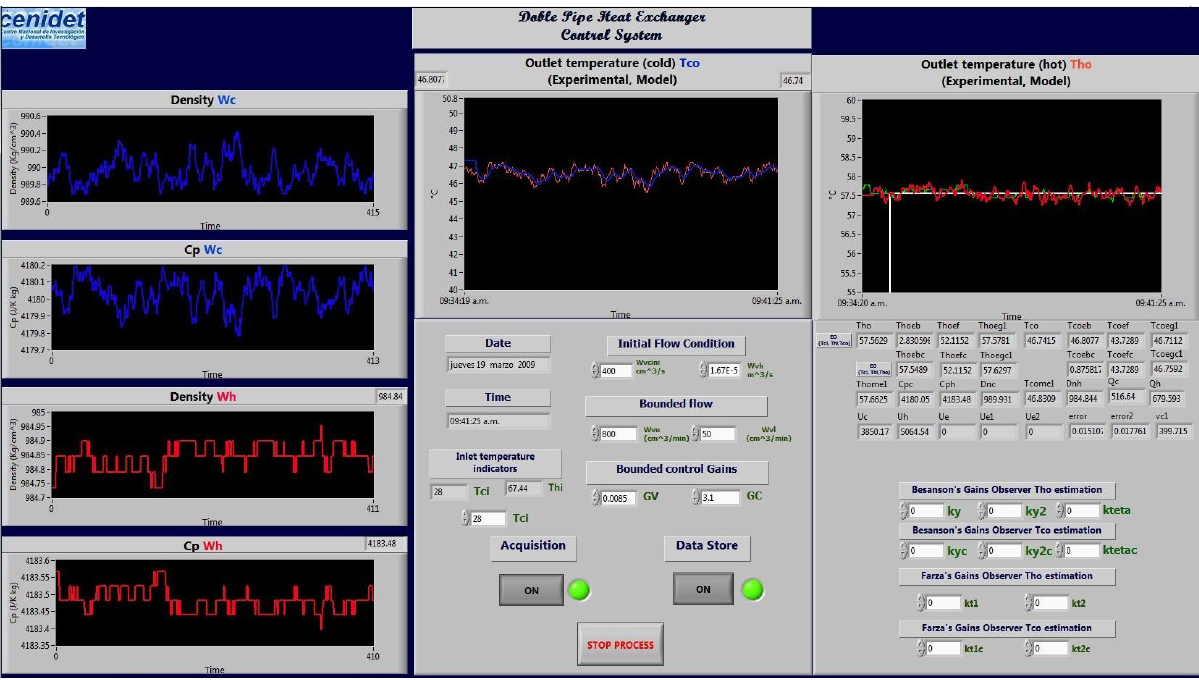
Figure 10. Main function graphical